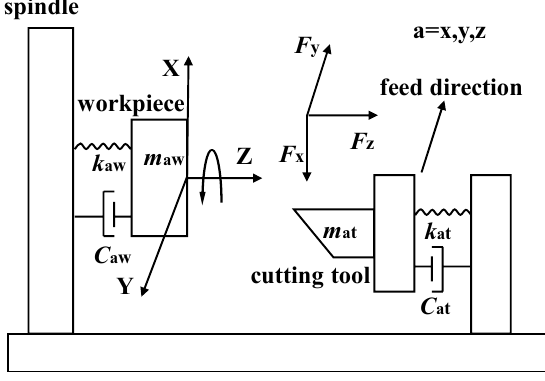
Figure 3. Machining process simulated by the dynamic response model.